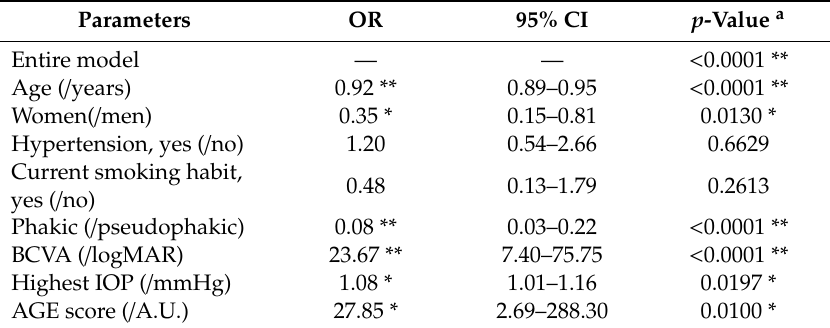
Table 5. Multivariate logistic regression analysis for risk factors of